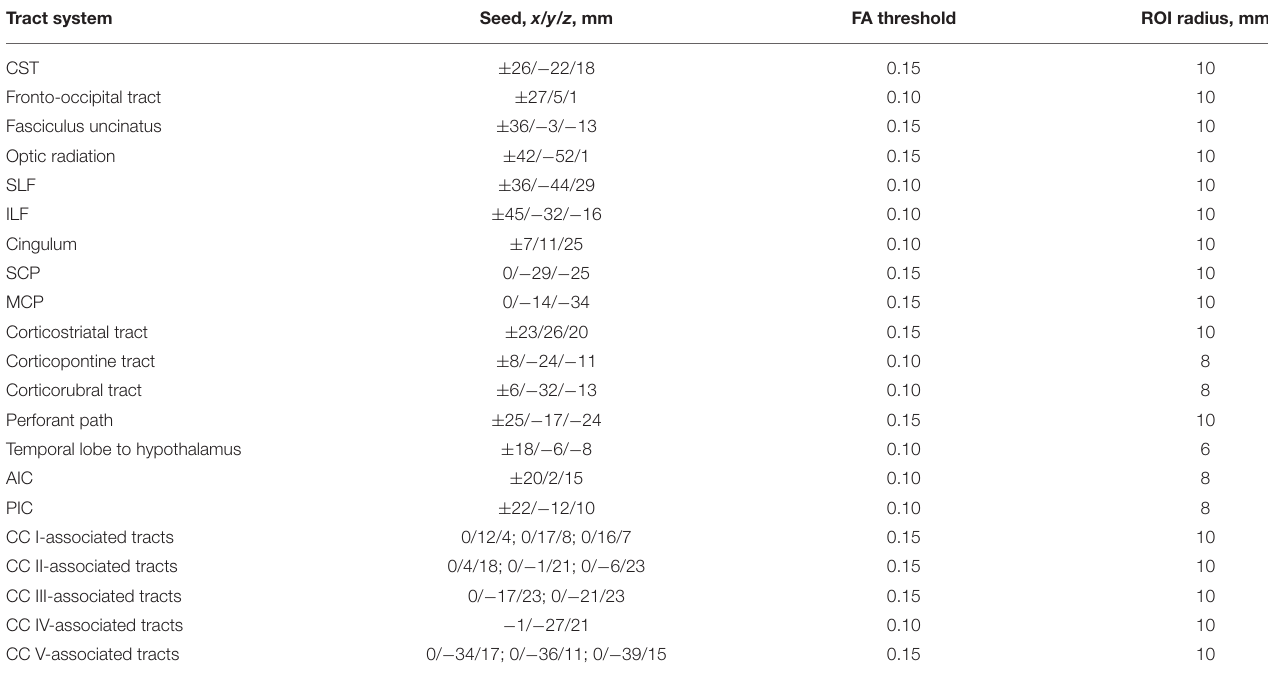
TABLE 1 | Montreal Neurological Institute (MNI) coordinates and radius for seed ROIs and the used FA threshold for the respective fiber tracking (CC, corpus callosum; CST, corticospinal tract; SLF, superior longitudinal fasciculus; ILF, inferior longitudinal fasciculus; SCP, superior cerebellar peduncle; MCP, middle cerebellar peduncle; AIC, anterior limb of internal capsule; PIC, posterior limb of internal